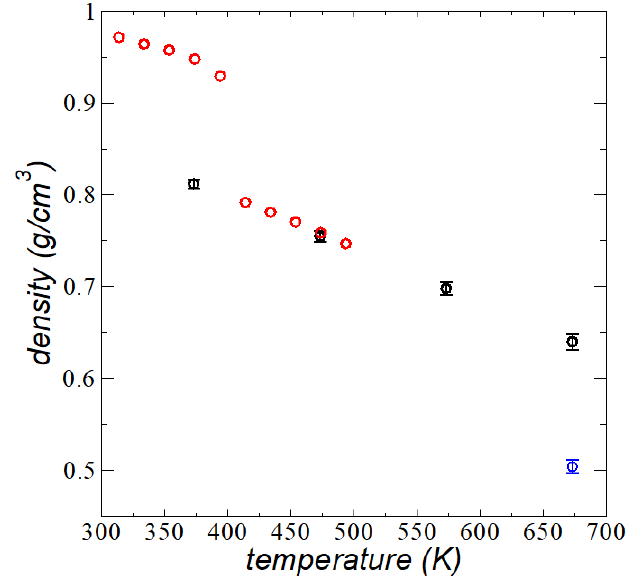
Figure 4. Bulk ρ l of thin liquid layers of melted polyethylene chains (C 200 ) in a liquid–vacuum equilibrium as a function of T . Black circles represent the results of this work using simulations. The blue circle represents a system simulated at a smaller r c (2.5 σ CH the standard deviation of the data. Red circles represent experimental results of Sato et al. for linear polyethylene at 0.1 MPa [Adapted from Ref. [42] with permission from Elsevier under License Number 5163721342541 (7 October